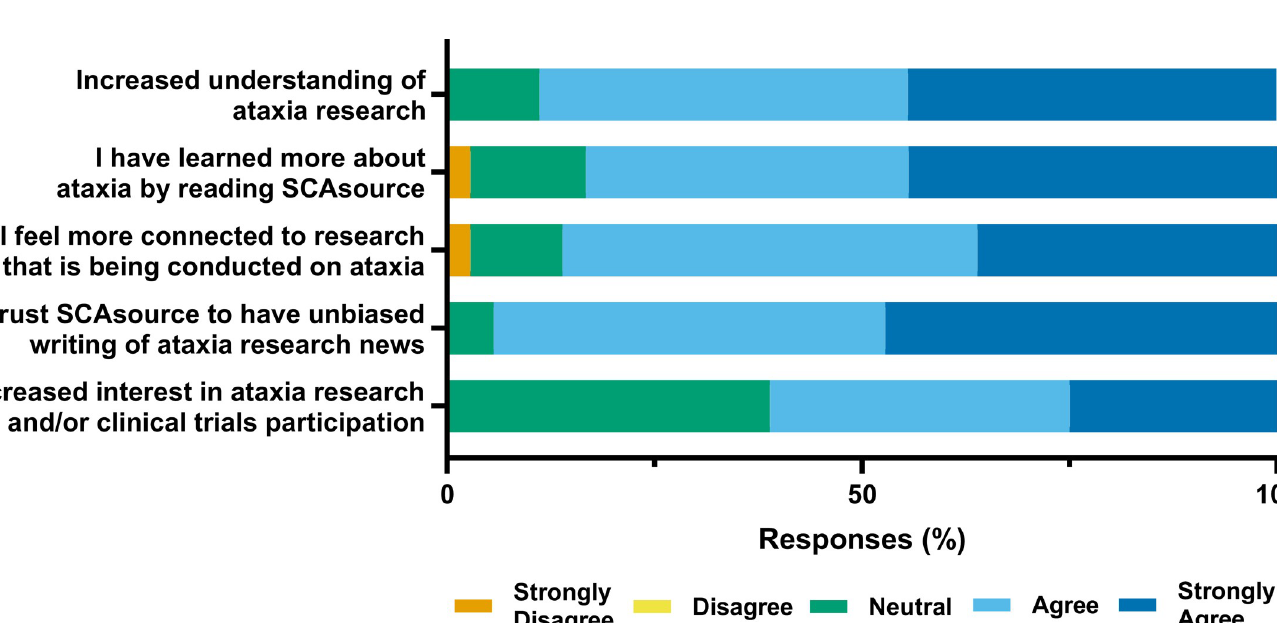
PLOS ONE | https://doi.org/10.1371/journal.pone.0238512 September 1,